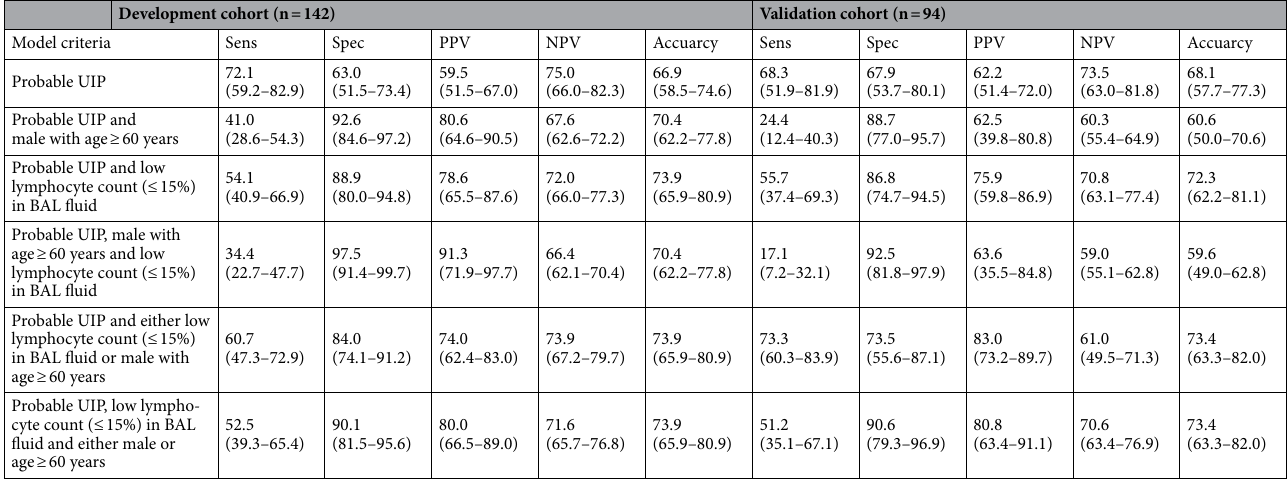
Table 5. Test characteristics of probable UIP pattern on CT alone and together with clinical features for IPF diagnosis in patients with CT pattern of non-definite UIP. Data in parentheses are 95% confidence intervals. HRCT high-resolution computed tomography; IPF idiopathic pulmonary fibrosis; PPV positive predictive value; NPV negative predictive value; AUC area under the receiver-operator characteristics curve; UIP usual interstitial pneumonia; BAL bronchoalveolar lavage.